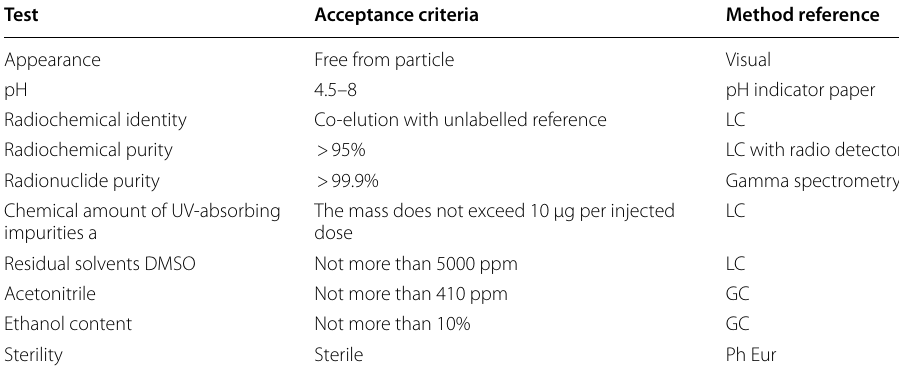
Table 5 Specifications for quality control of a novel RP: exemplified acceptance criteria and